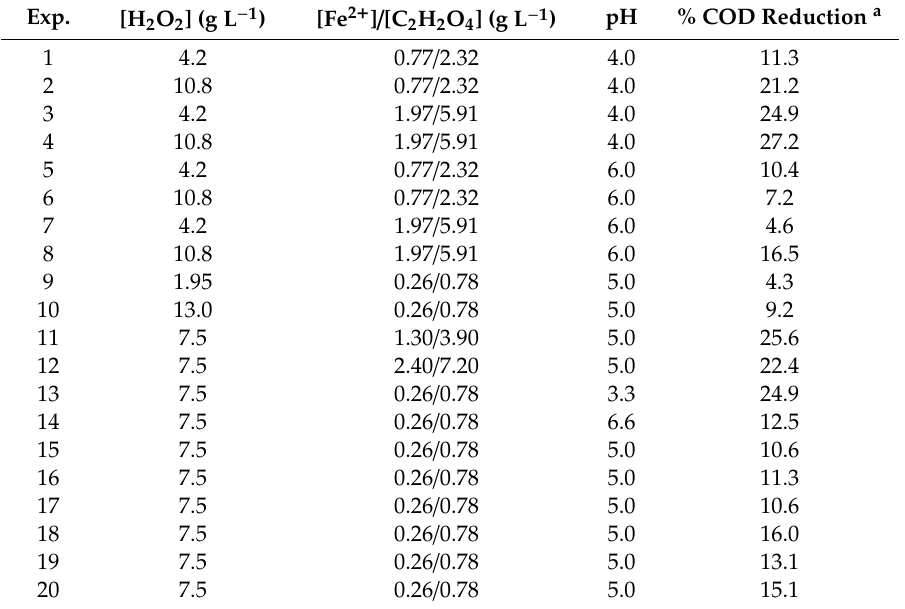
Table 7. The 3-factor central composite experimental design of solar photo-Fenton experiments for leachate pre-treated with FeCl 3 coagulant. Results of % COD reduction. Exp.